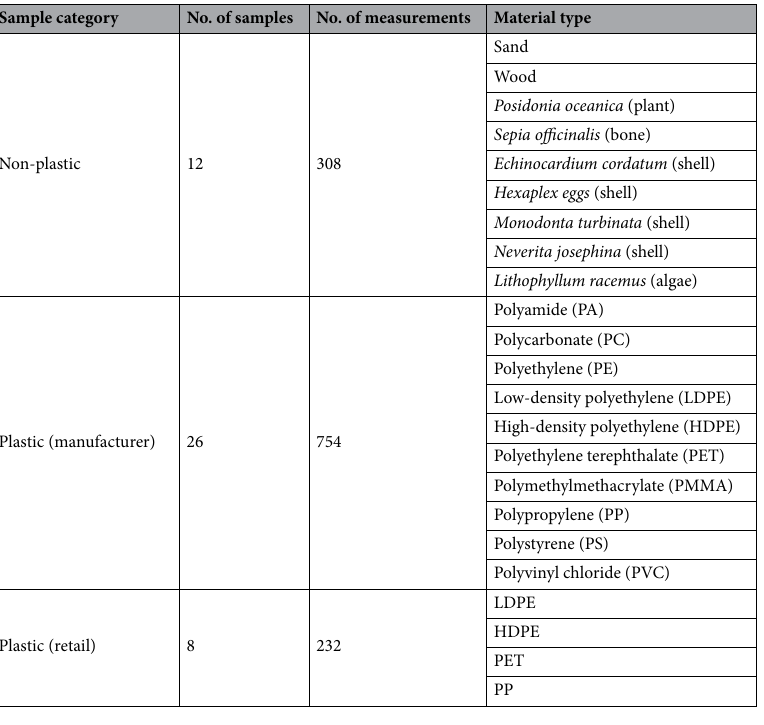
Table 3. Overview of samples used for this study.